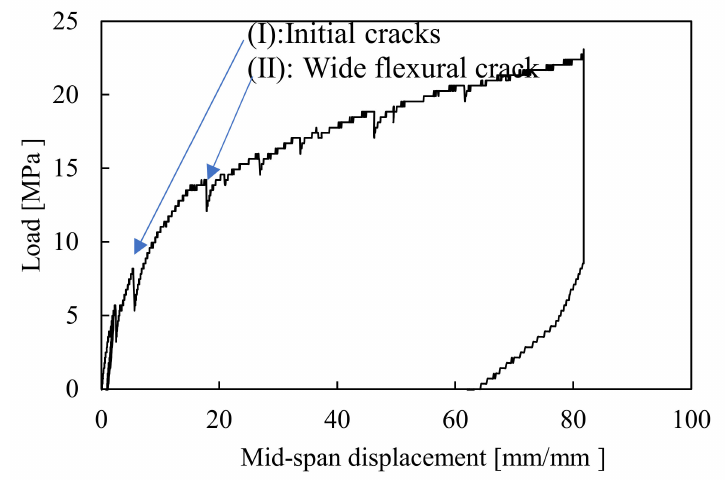
Figure 4. Load versus mid-span displacement curve of PCSP-1 specimen.